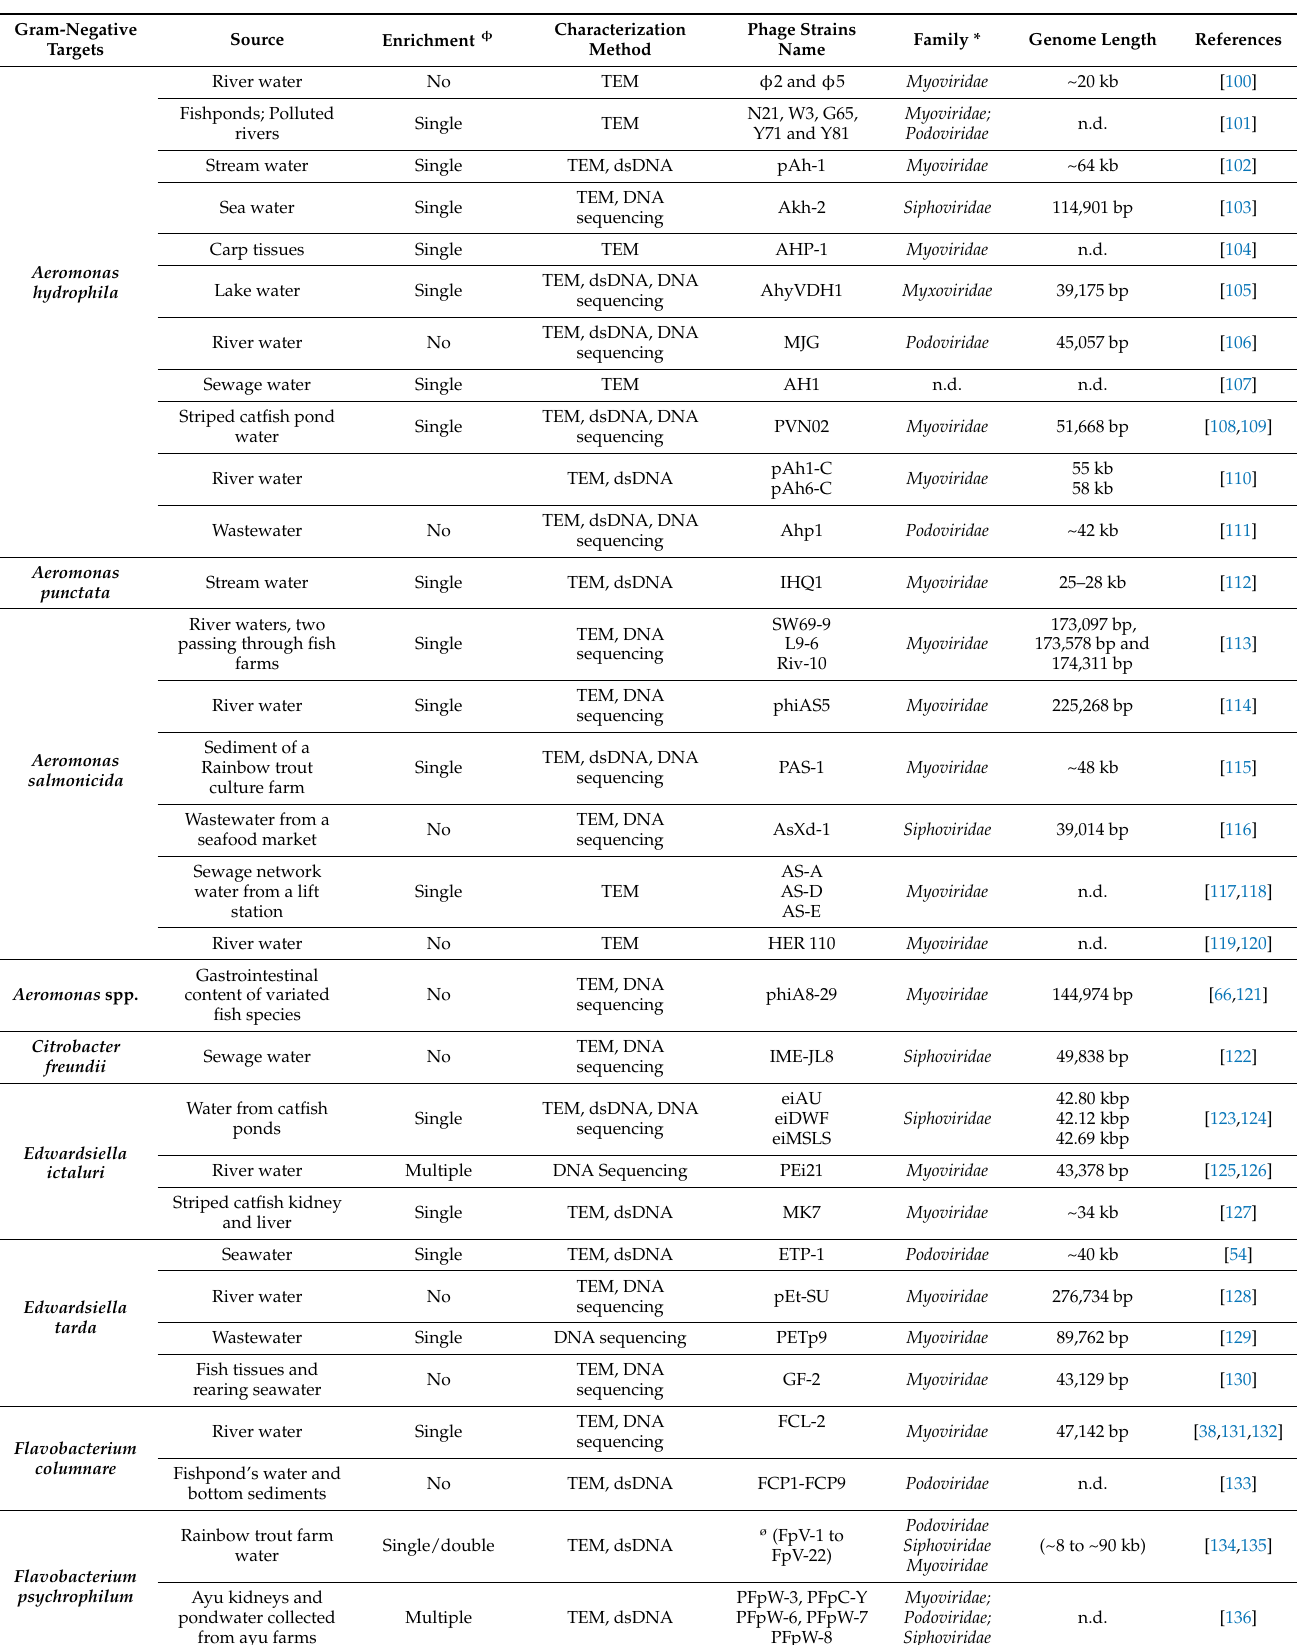
Table 1. Phages used against Gram-negative bacterial fish and shellfish